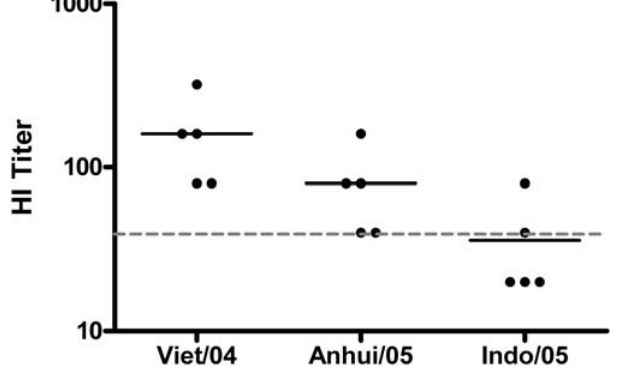
Figure 7. Hemagglutination inhibition activity in rhesus macaques following two immunizations. HI activity is shown for clade 1 (A/Vietnam/1203/04), clade 2.1 (A/Anhui/01/05), and a more divergent clade 2.1 (A/Indonesia/05/05). Naı¨ve monkeys showed no detectable HI activity against any of the indicated strains.